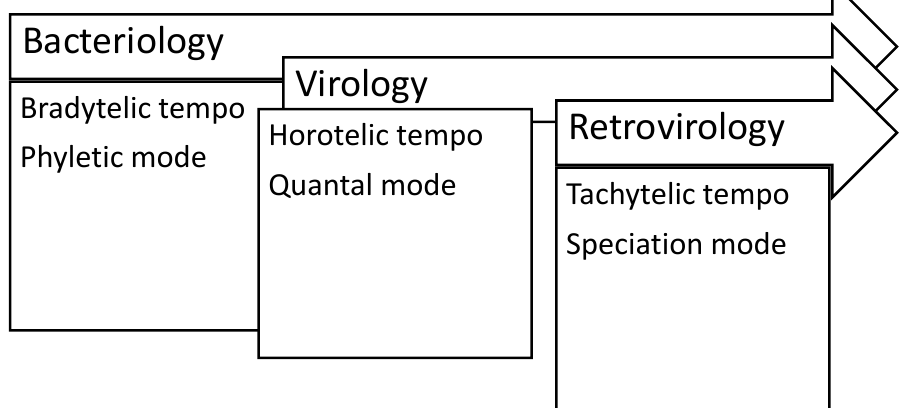
Figure 1. The evolutionary relationship of microbiological specialties of bacteriology and virology, as